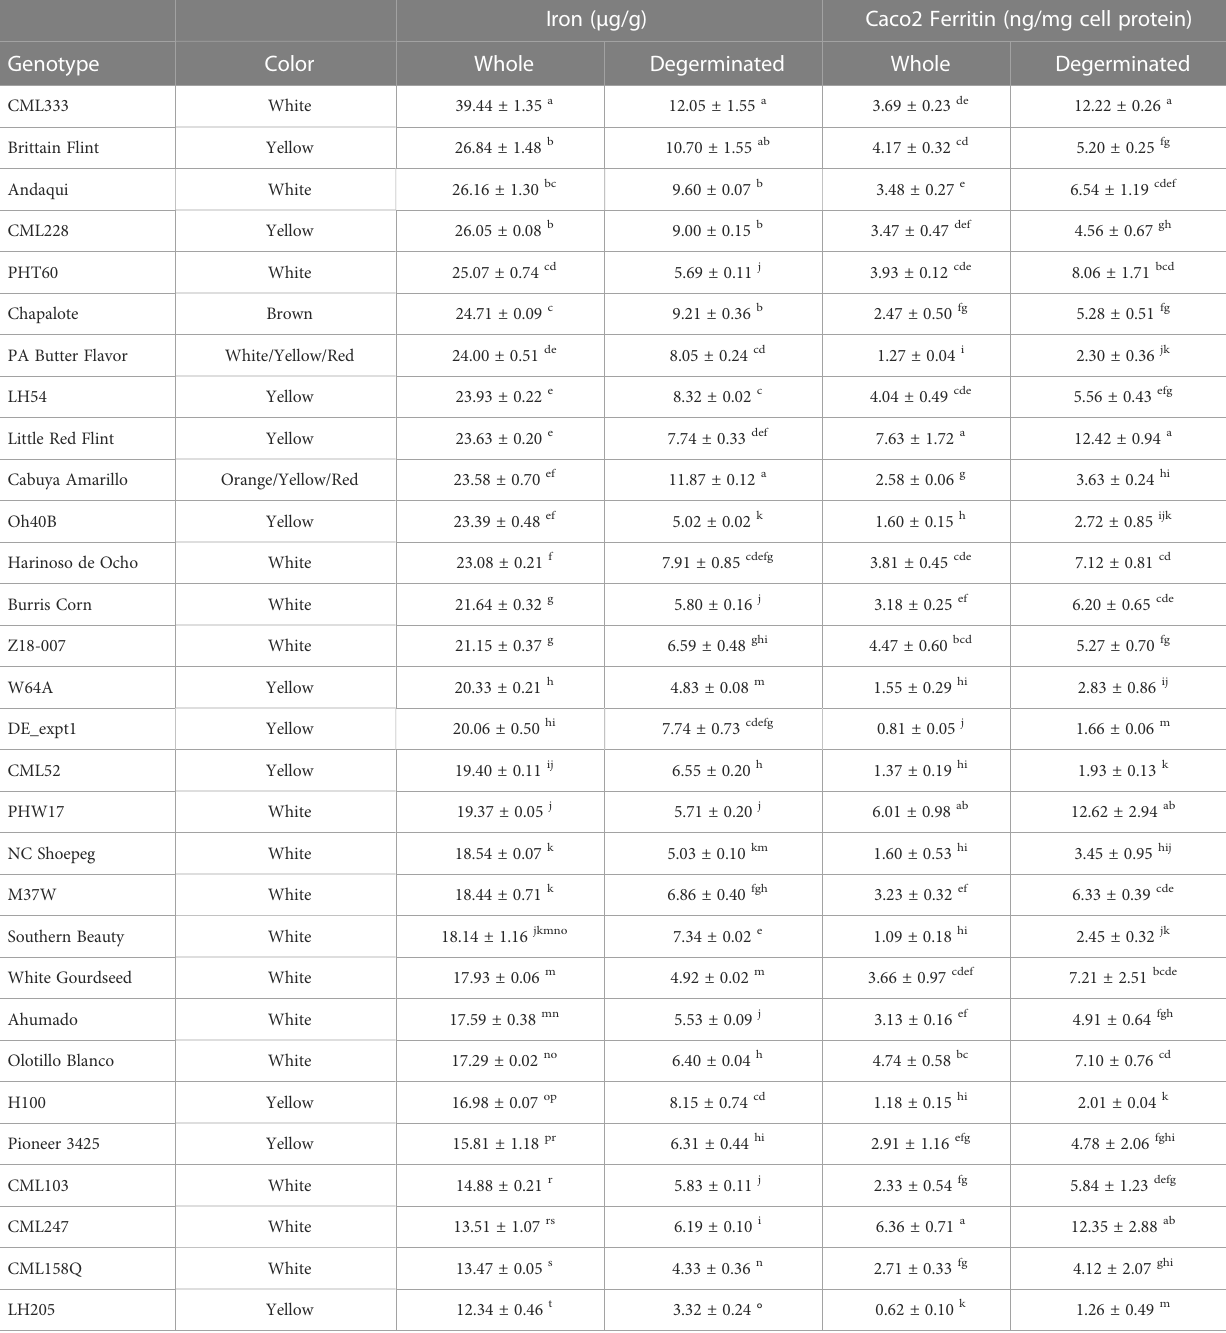
1 Values are means ± standard deviation of three measurements from each genotype after cooking. Iron concentrations are expressed as micrograms per gram of cooked, lyophilized and milled maize sample (dry weight). Iron bioavailability is expressed as Caco2 cell ferritin formation (ng ferritin/mg total cell protein) after exposure to an in vitro digestion of a cooked, lyophilized and milled maize sample. Mean values sharing the same superscripts in each column are not signi fi cantly different at P ≤ ratios after degermination reveal that Fe and Zn may have average phytate:Fe molar ratios, from 31.1 ± 7.9 to 15.5 ± 5.4 (Figure 2; Table S2). Overall, phytate and Fe concentrations were positively correlated among whole and degeminated maize genotypes in the MNP and for all color groups besides white maize (Table 5). The loss of phytate, Fe and Zn after removing the germ fraction indicates that these compounds and elements are colocalized within the germ fraction (Figures 2, 3; Tables S2-S3). However, the large reductions in phytate:Fe and phytate:Zn molar